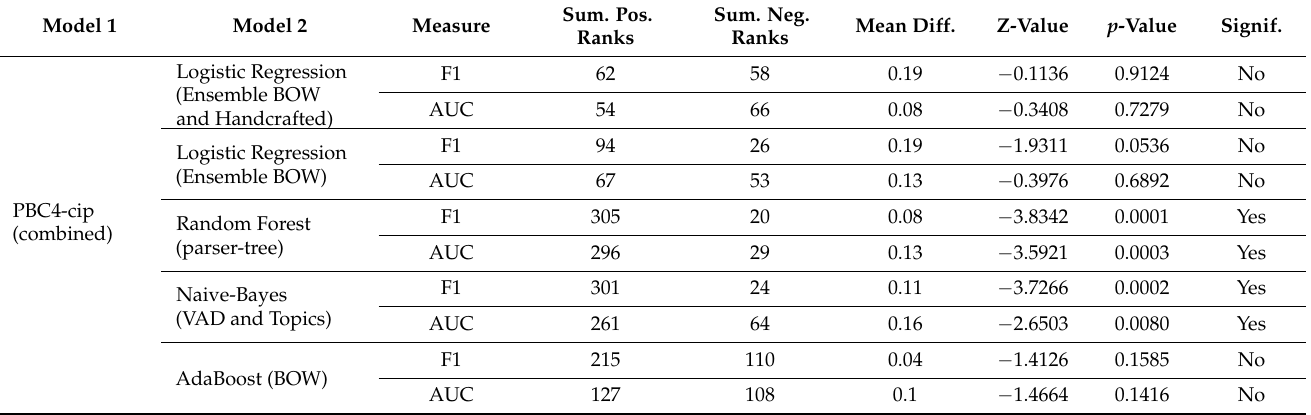
Table 8. Wilcoxon signed-ranks test, comparing the classification results of our proposal against the remaining tested popular state-of-the-art